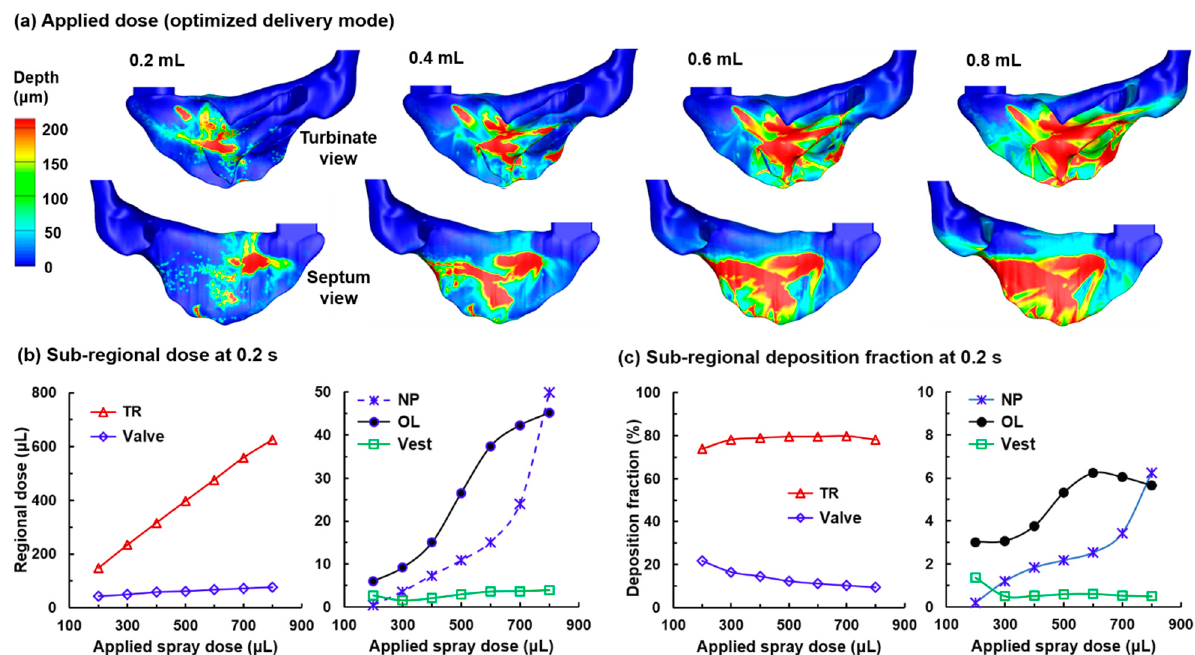
Figure 10. Nasal spray delivery with different applied doses and the optimal delivery system: ( a ) liquid film distribution at 0.2 s after applying a spray dose of 0.2 mL, 0.4 mL, 0.6 mL, and 0.8 mL; ( b ) subregional dosages in the TR, valve, NP, OL, and Vest as a function of applied spray dose; ( c ) subregional deposition fraction in the TR, valve, NP, OL, and Vest as a function of applied spray dose.